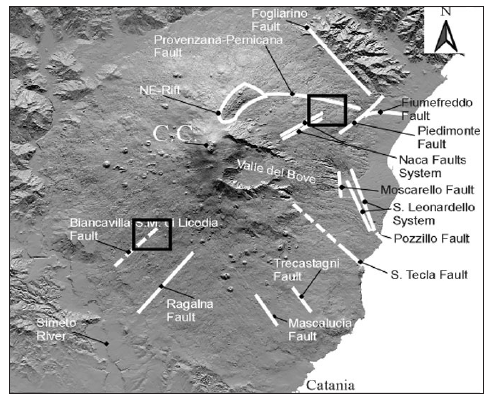
Fig. 1. Map of the sites location: SW Biancavilla; NE Vena (Piedimonte Etneo) and fault-system in the Etna